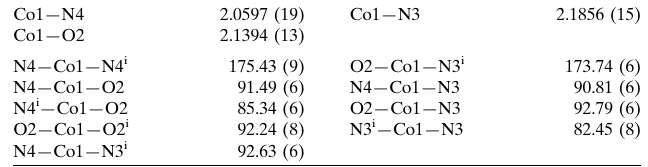
Selected geometric parameters (A˚ , (cid:1) ).